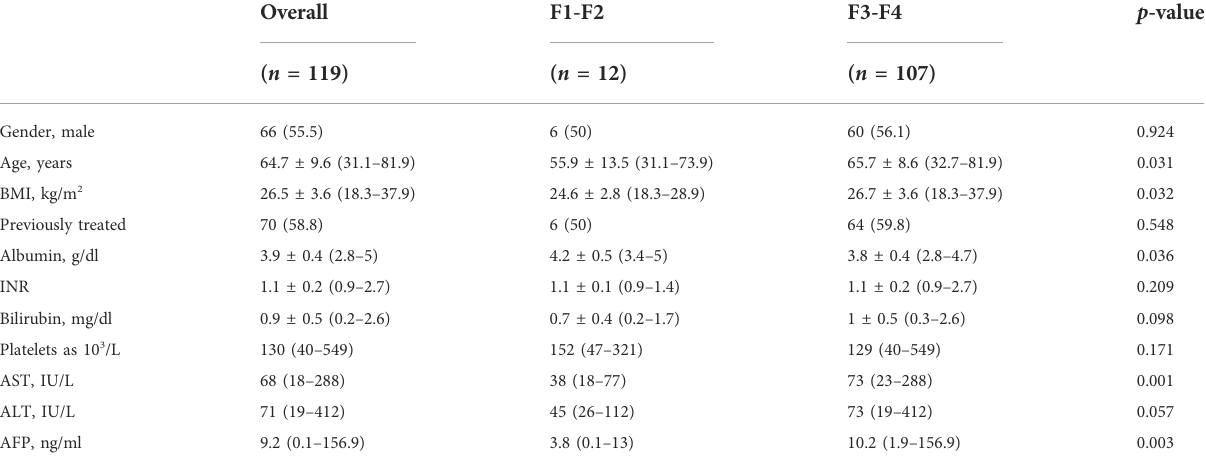
TABLE 1 Baseline demographic, clinical, and laboratory characteristics of 119 patients; overall and strati fi ed to liver fi brosis according to TE values. Overall F1-F2